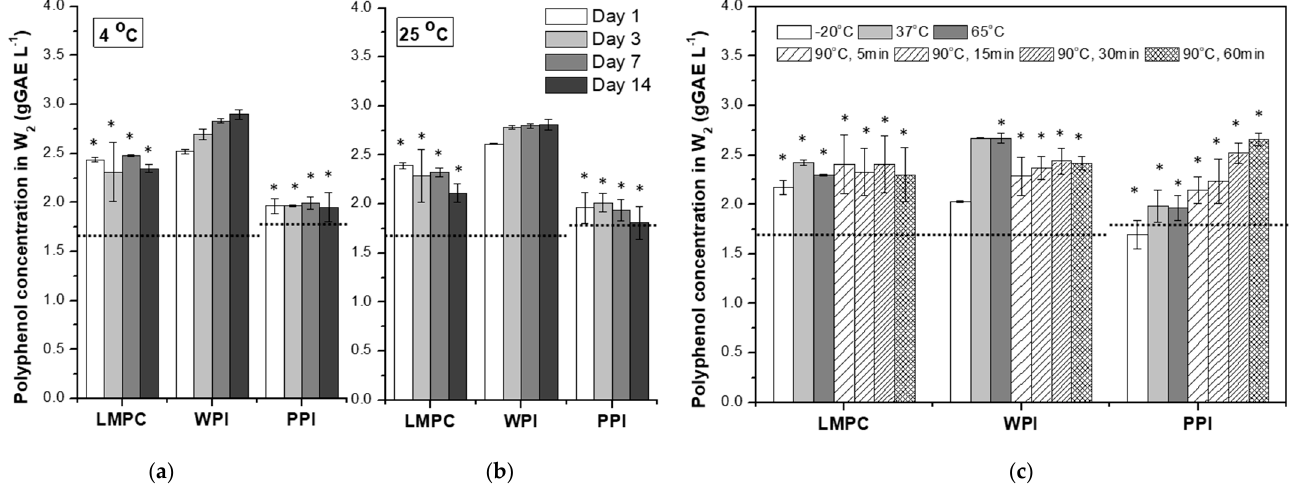
Figure 10. Polyphenol concentration in W 2 of emulsions ( 𝐶 (cid:3043)(cid:3042)(cid:3039)(cid:3052) ) stabilized with LMPC, WPI and PPI during storage at 4 ( a ) and 25 ◦ C ( b ) over 14 days, and ( c ) after being subjected to different temperature stresses: –20 ◦ C (24 h), 37 ◦ C (30 min), 65 ◦ C (30 min) and 90 ◦ C (5, 15, 30, and 60 min). Asterisk labels above the bars point to the appearance of a precipitate during polyphenol analysis. Dashed lines indicate the value for freshly produced emulsions.